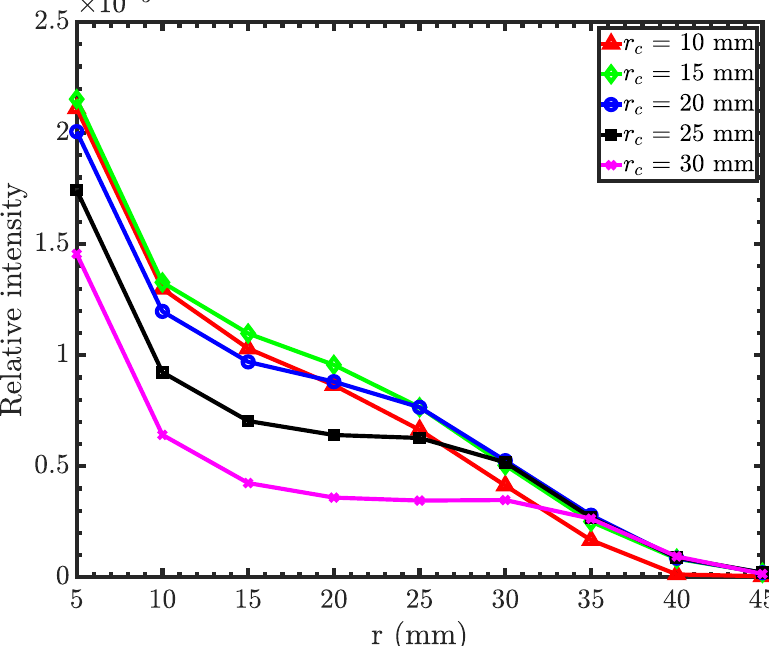
Figure 6. Relative intensity as a function of the objective mirror minimum radius for different condenser minimum radii. The condenser and objective focal lengths are 750 mm (Wolter I